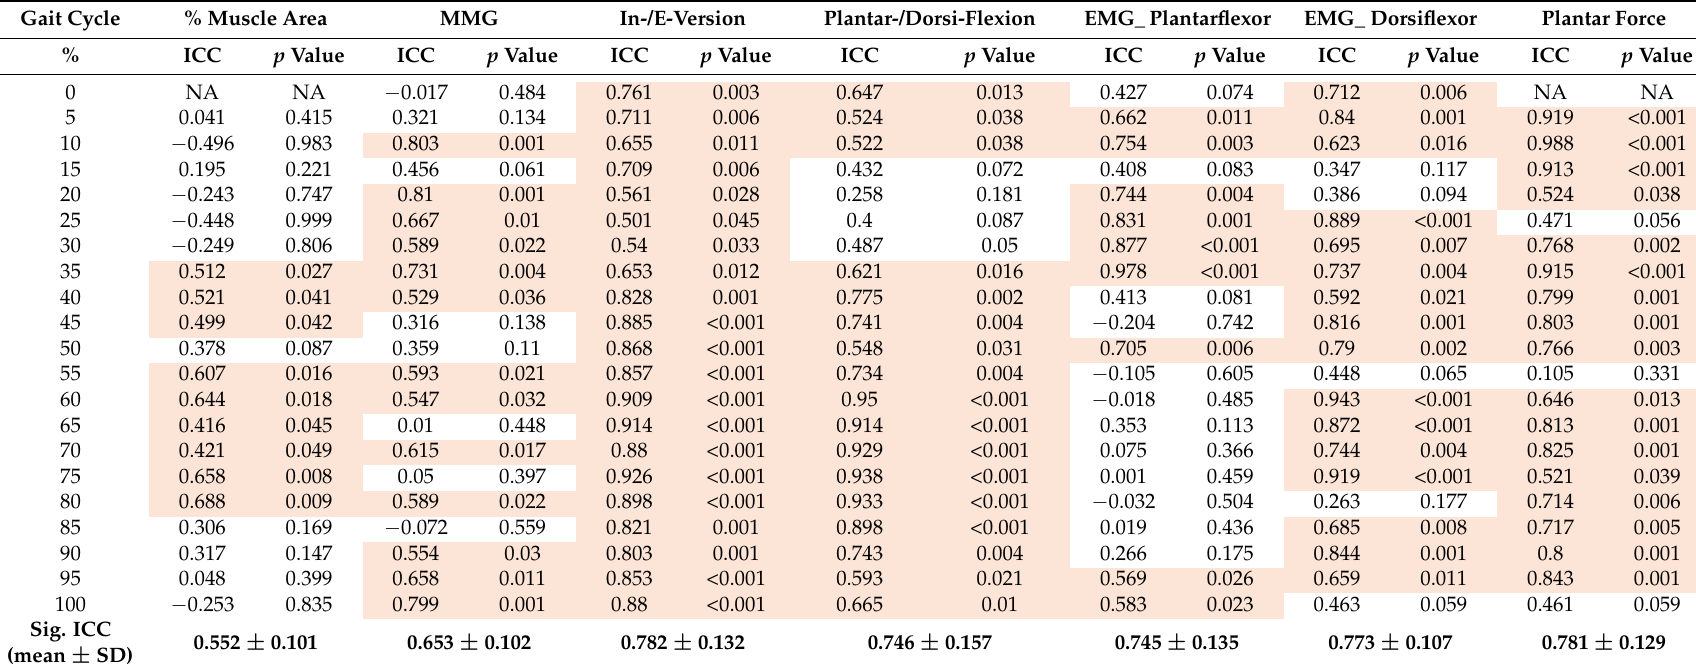
Table 1. Statistical results of reproducibility of the mobile SMG device during a gait cycle of ten healthy